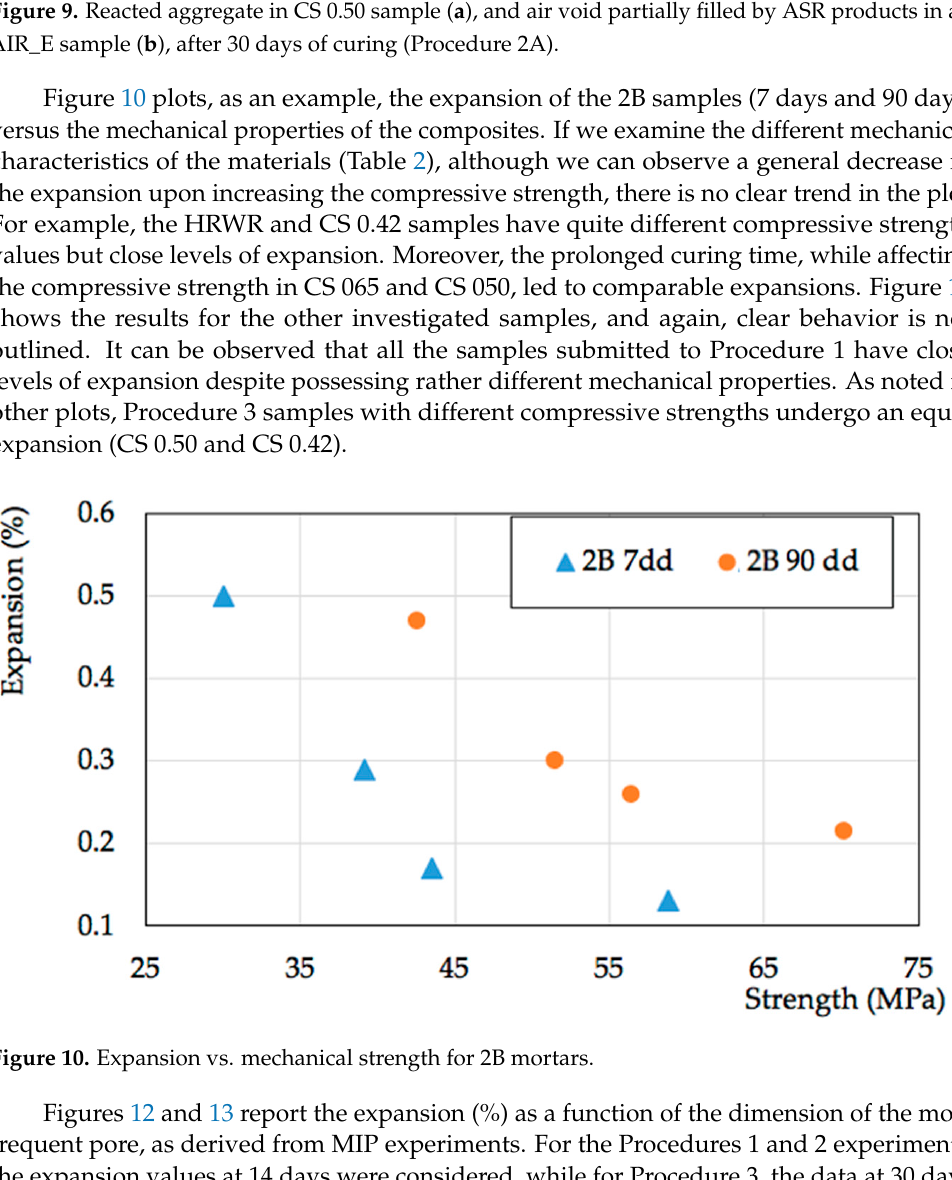
Figure 9. Reacted aggregate in CS 0.50 sample ( a ), and air void partially filled by ASR products in an AIR_E sample ( b ), after 30 days of curing (Procedure 2A).